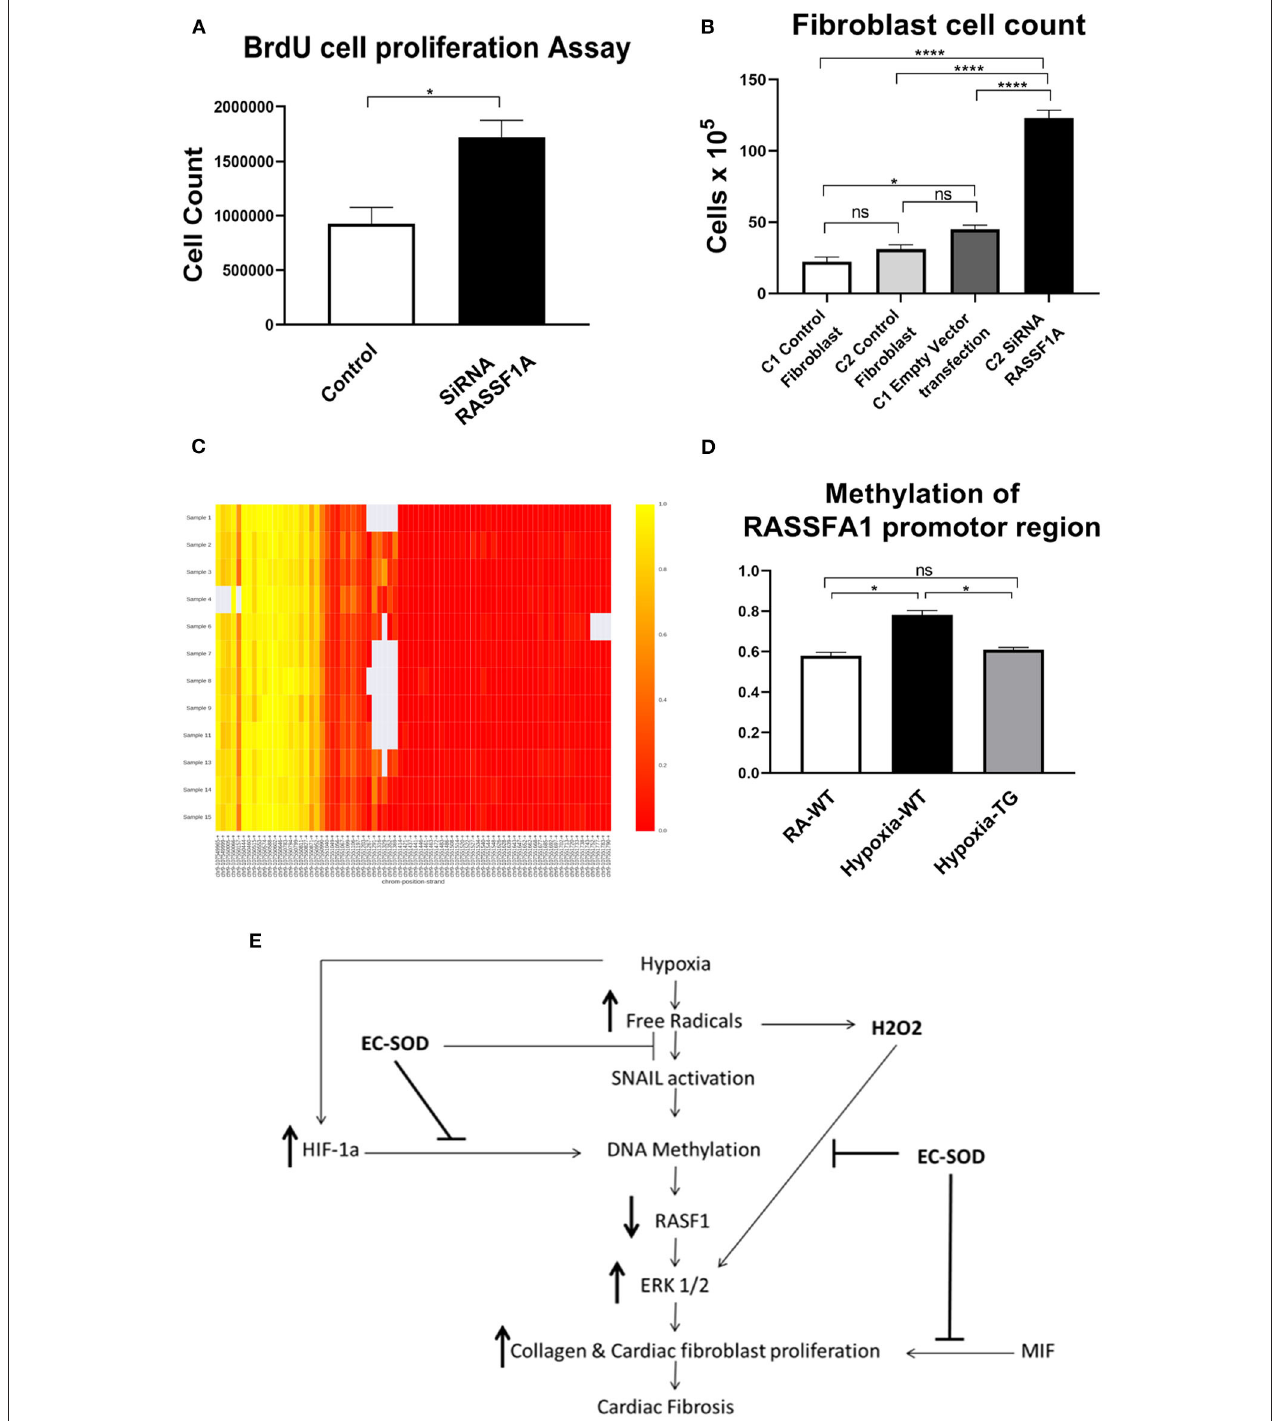
FIGURE 8 | Cell proliferation studies after transfection with SiRNA for RASSF1A—Cardiac fibroblasts were transfected with SiRNA for RASSF1A and compared to cells placed in RA which served as a control. BrdU cell proliferation studies were undertaken (A) , and cells as having underwent cell counts (B) . DNA methylation studies of the RASSF1A promotor region as shown in the heat map: RA group (samples 1–4); WT hypoxic group (Samples 6–9); TG hypoxic group (samples 11–15) (C) . Quantitative estimation of methylation level among the three studied groups (D) . Proposed mechanism (E) . Data represent mean ± SEM. * P < 0.05, ** P < 0.01, *** P < 0.001, **** P <